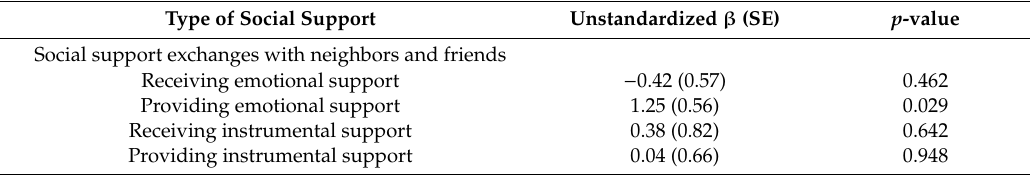
Table 3. The e ff ects of subcomponents of social support exchanges with neighbors and friends on cognitive function at one-year